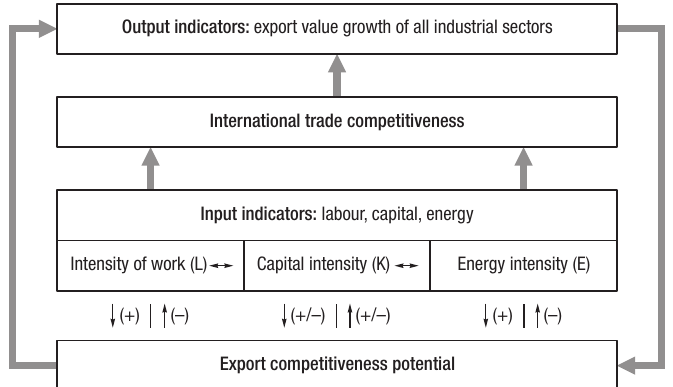
Ou t pu t indic ators : export value growth of all industrial